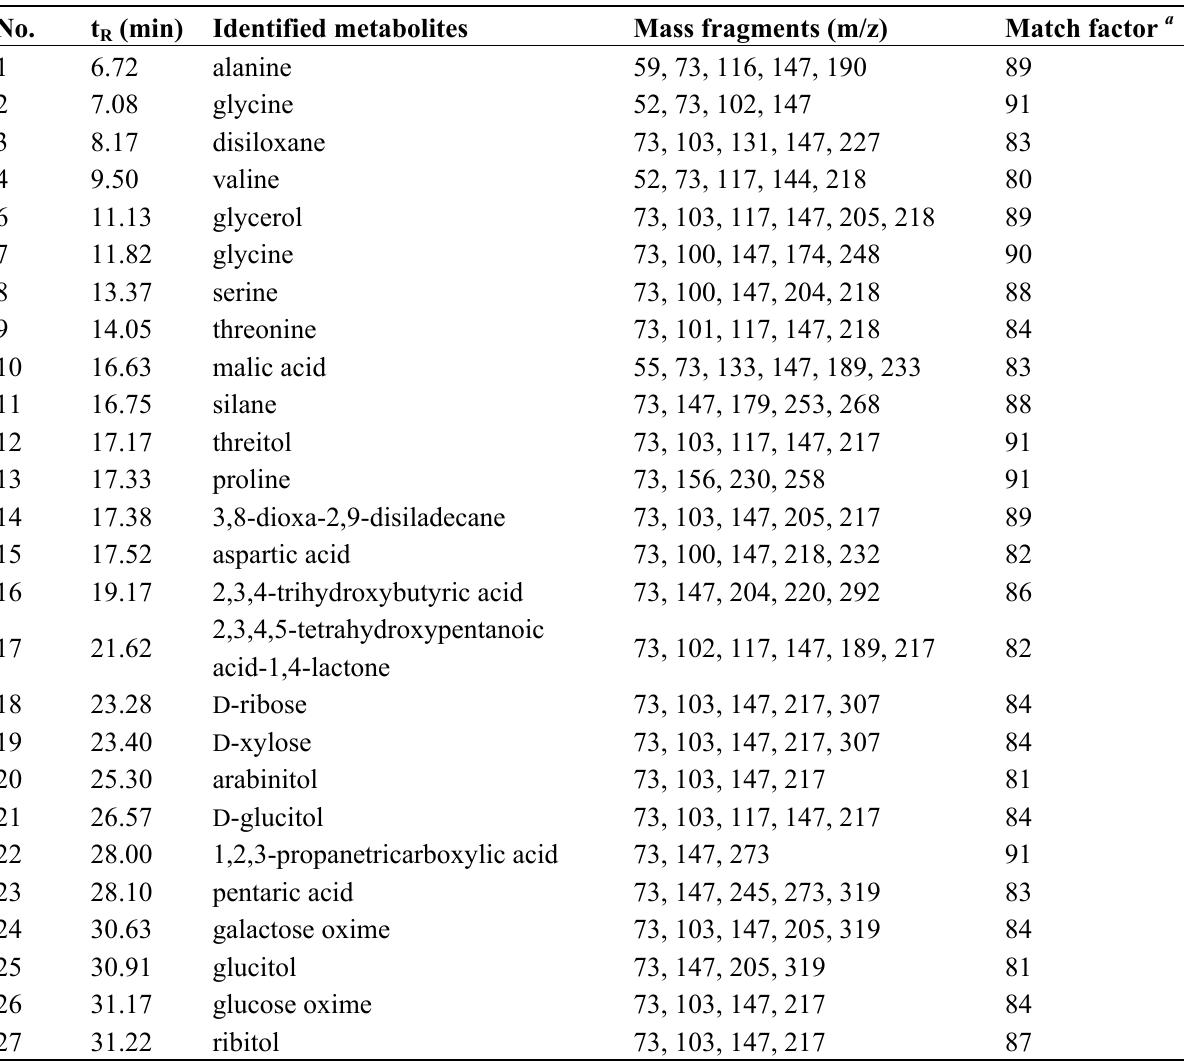
Table 2. Retention times, mass fragments, and match factors of detected metabolites in G. elata by